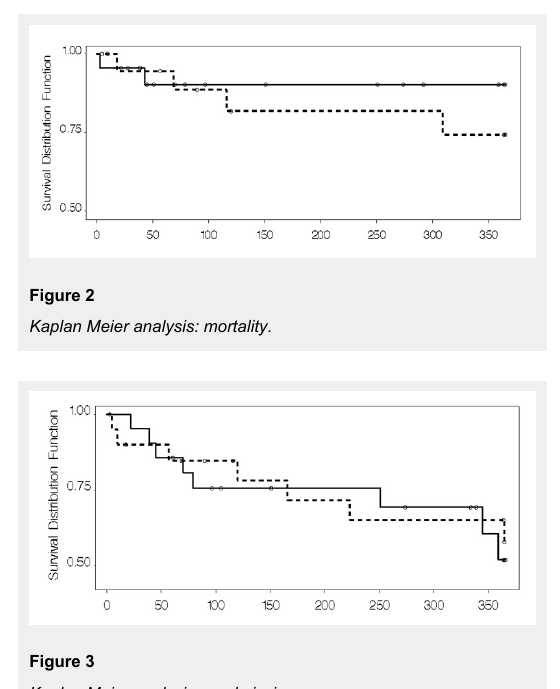
Minnesota Living with Heart Failure Questionnaire.